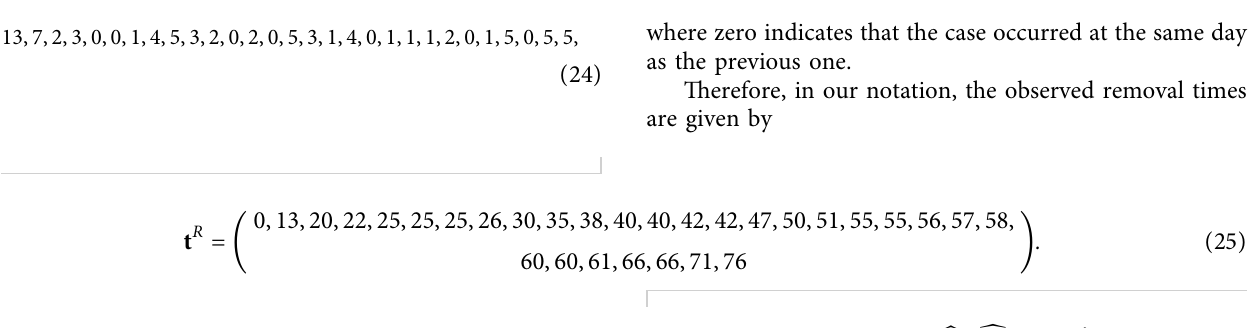
, where c value is set to 1. Each row is obtained based on the average of 10 0